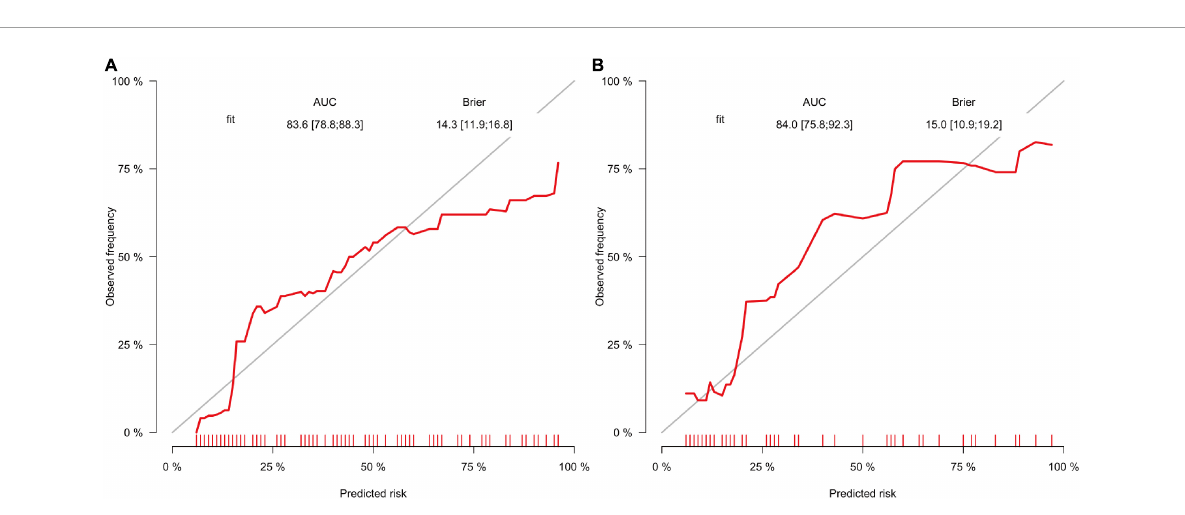
FIGURE6 (A,B) Calibration plot for two external datasets which show the AUC and Brier